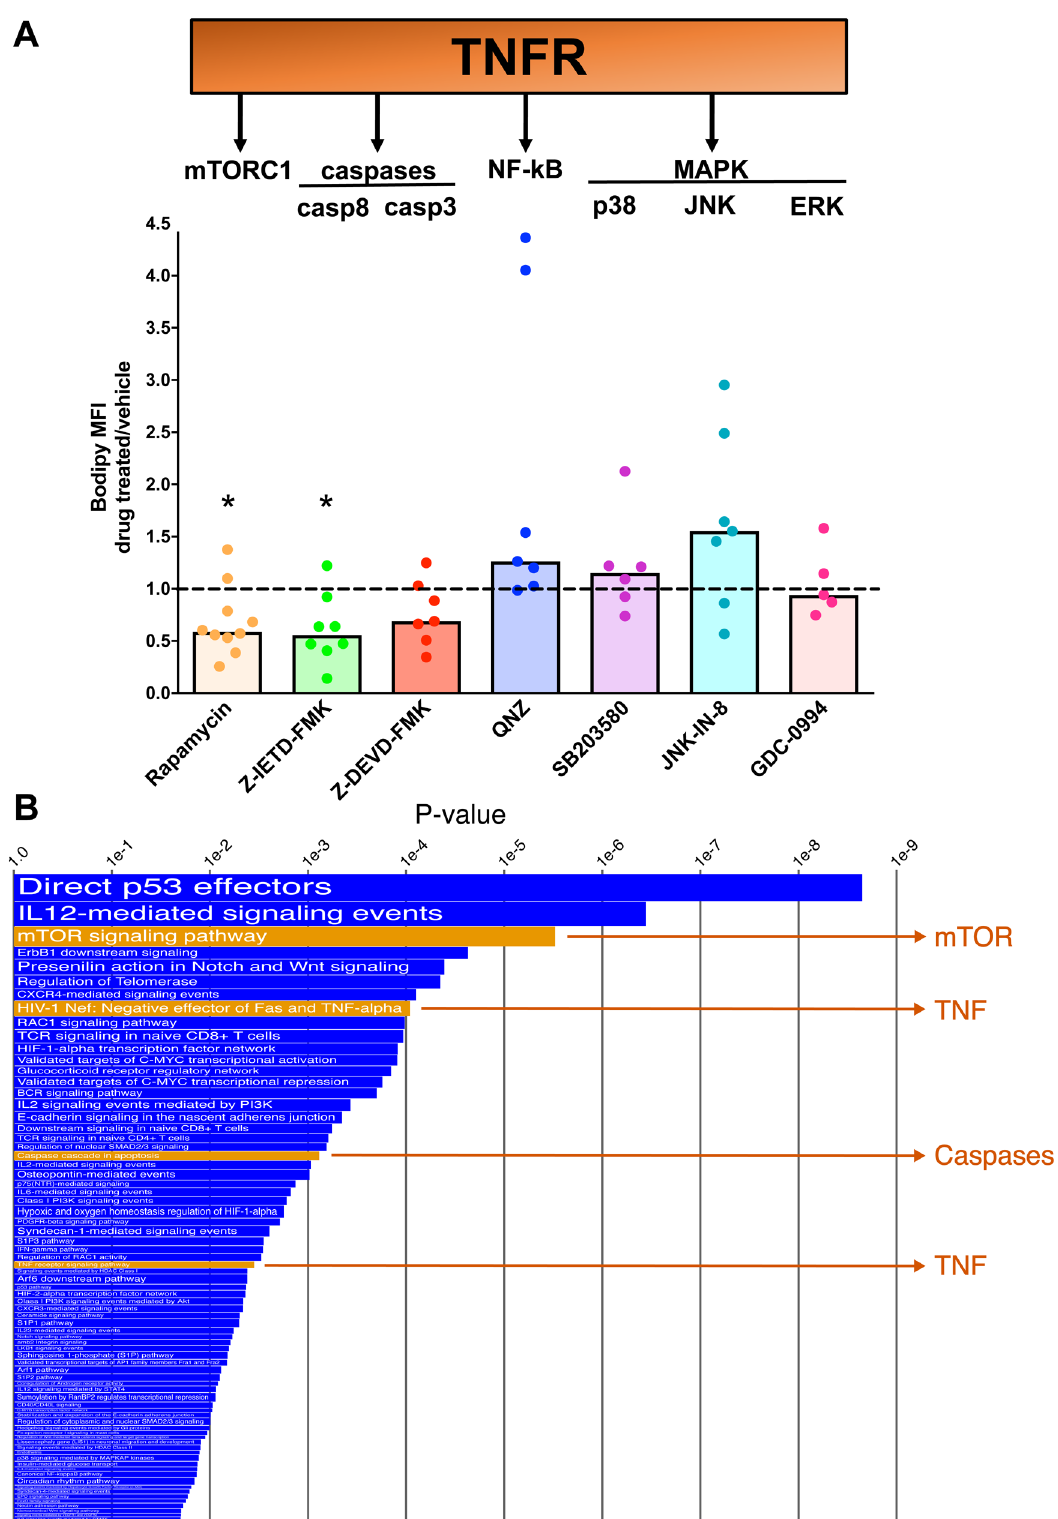
Fig 5. Role of TNFR-mediated pathways in lipid droplet formation in M . tuberculosis- infectedmacrophages. ( A ) Effect of pathway inhibitors on lipid droplet content of infected macrophages. The scheme at the top of the figure shows the intracellular